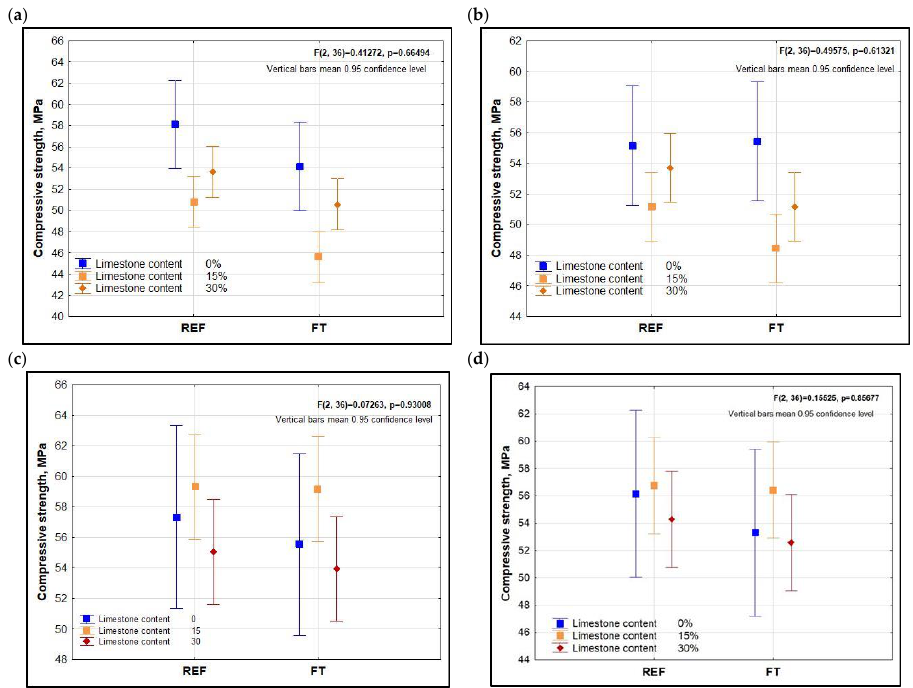
Figure 12. ANOVA analysis of the amount of limestone on the compressive strength for reference samples (REF) and samples after 100 cycles of freeze – thaw (FT) for ( a ) vibrated concretes without AEA, ( b ) SCC without AEA, ( c ) vibrated concretes with AEA, ( d ) SCC with AEA. The concrete type did not affect the freeze – thaw resistance after 100 cycles — for both self-compacting and vibrated concrete, the compressive strength loss was comparable, which can be seen in Figure 13, showing the ANOVA analysis of the effect of concrete type on strength. It should be noted that the compressive strength of SCC was consistently slightly lower than in the case of the corresponding vibrated concretes, which may be connected with the higher air content. SCC mixes were characterized by 1% higher air content, which means higher porosity and thus lower compressive strength.